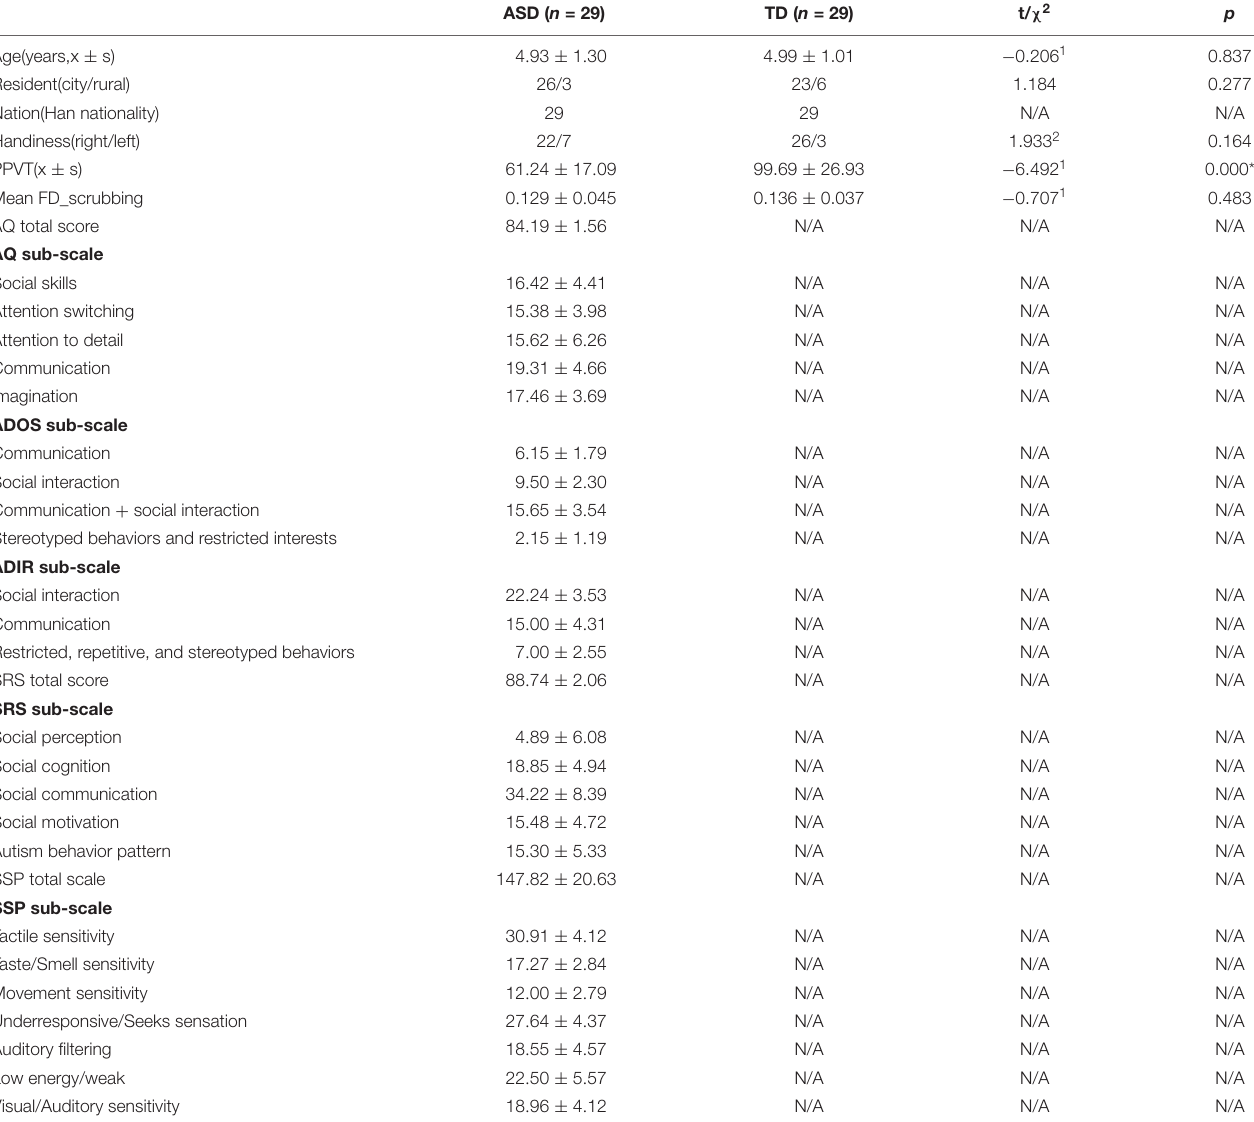
TABLE 1 | Demographic data (means ± SD) of ASD and TD